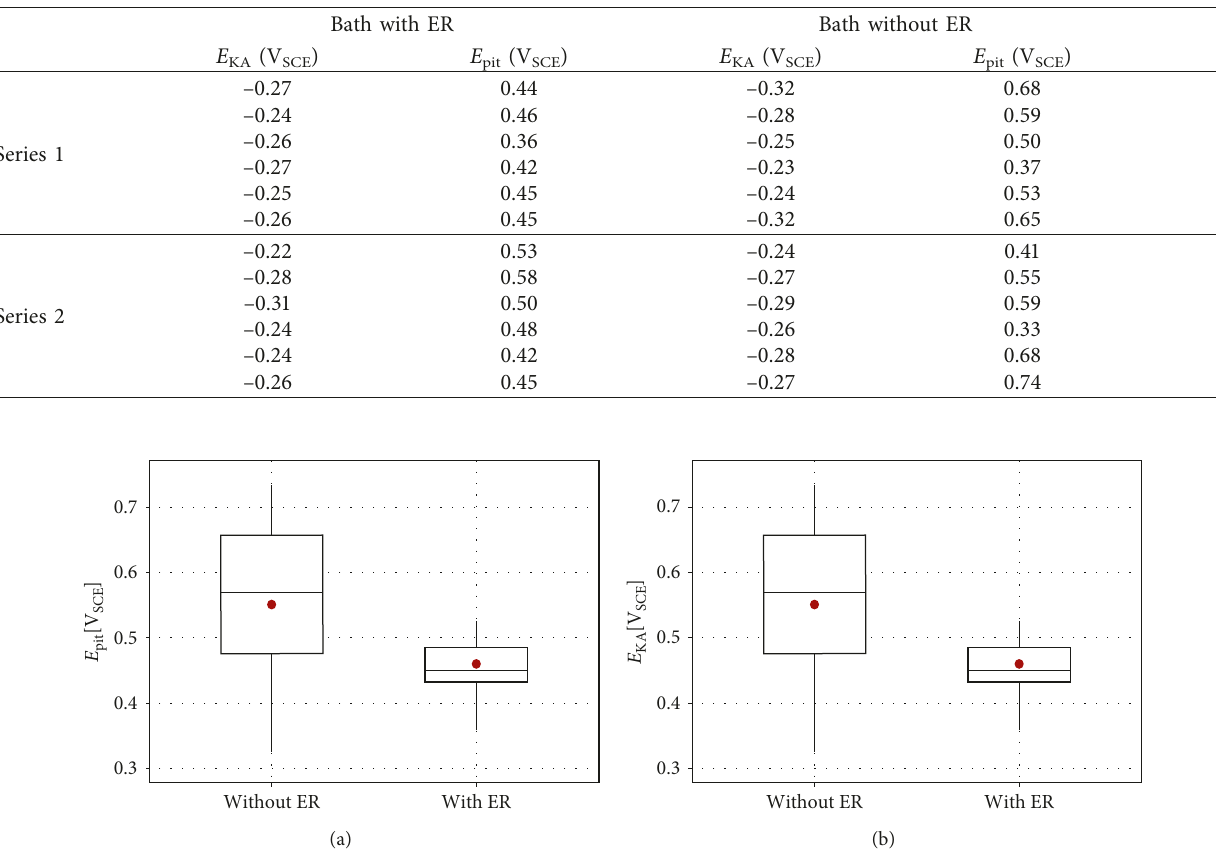
Figure 8: Potentiodynamic curves obtained in 0.5M environment of NaCl solution for samples:1, sample electropolished in a bath with ER; 2, sample electropolished in a bath without ER. Table 3: Critical pitting development potential E pit and the cathodic-anodic transfer potential E KA for samples electropolished in baths with and without ER.